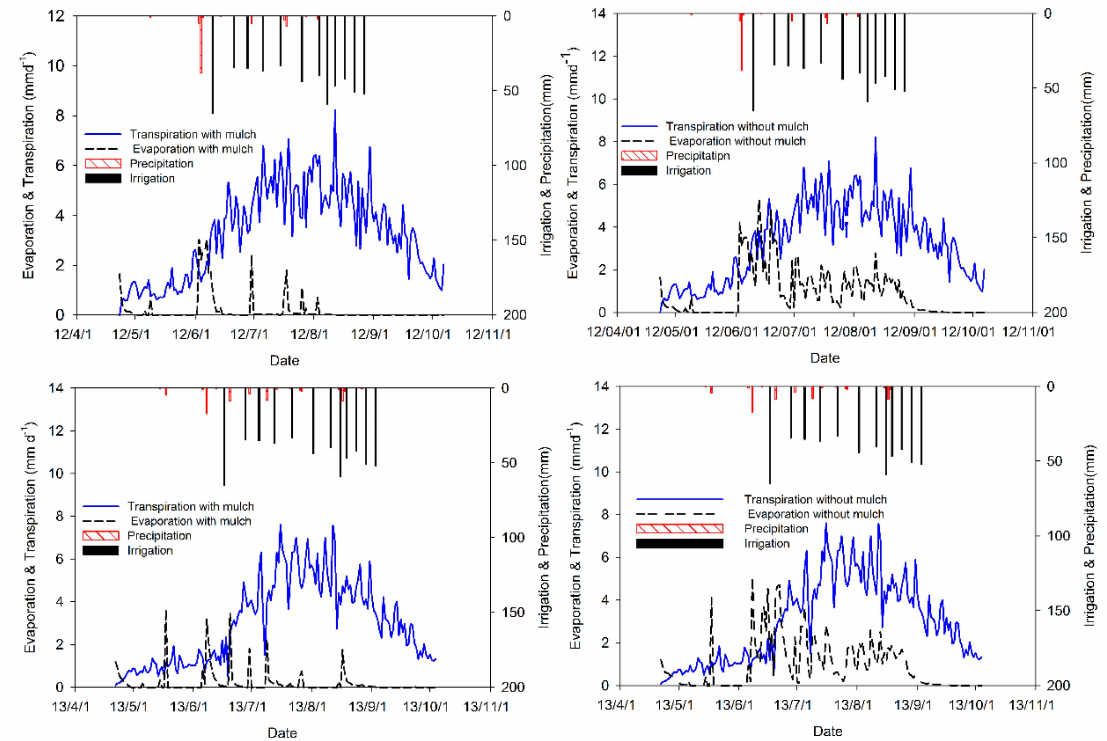
Figure 6. Daily variation of evaporation and transpiration for cotton in 2012–2013 (with and without mulch).